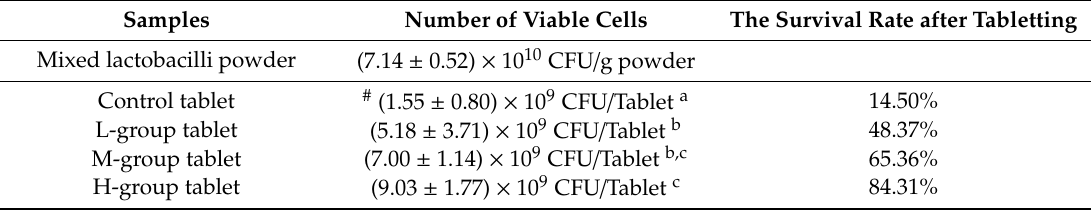
Table 3. Viability of lactobacilli cells in the mixed lactobacilli powder before tabletting and in di ff erent kinds of lactobacilli e ff ervescent